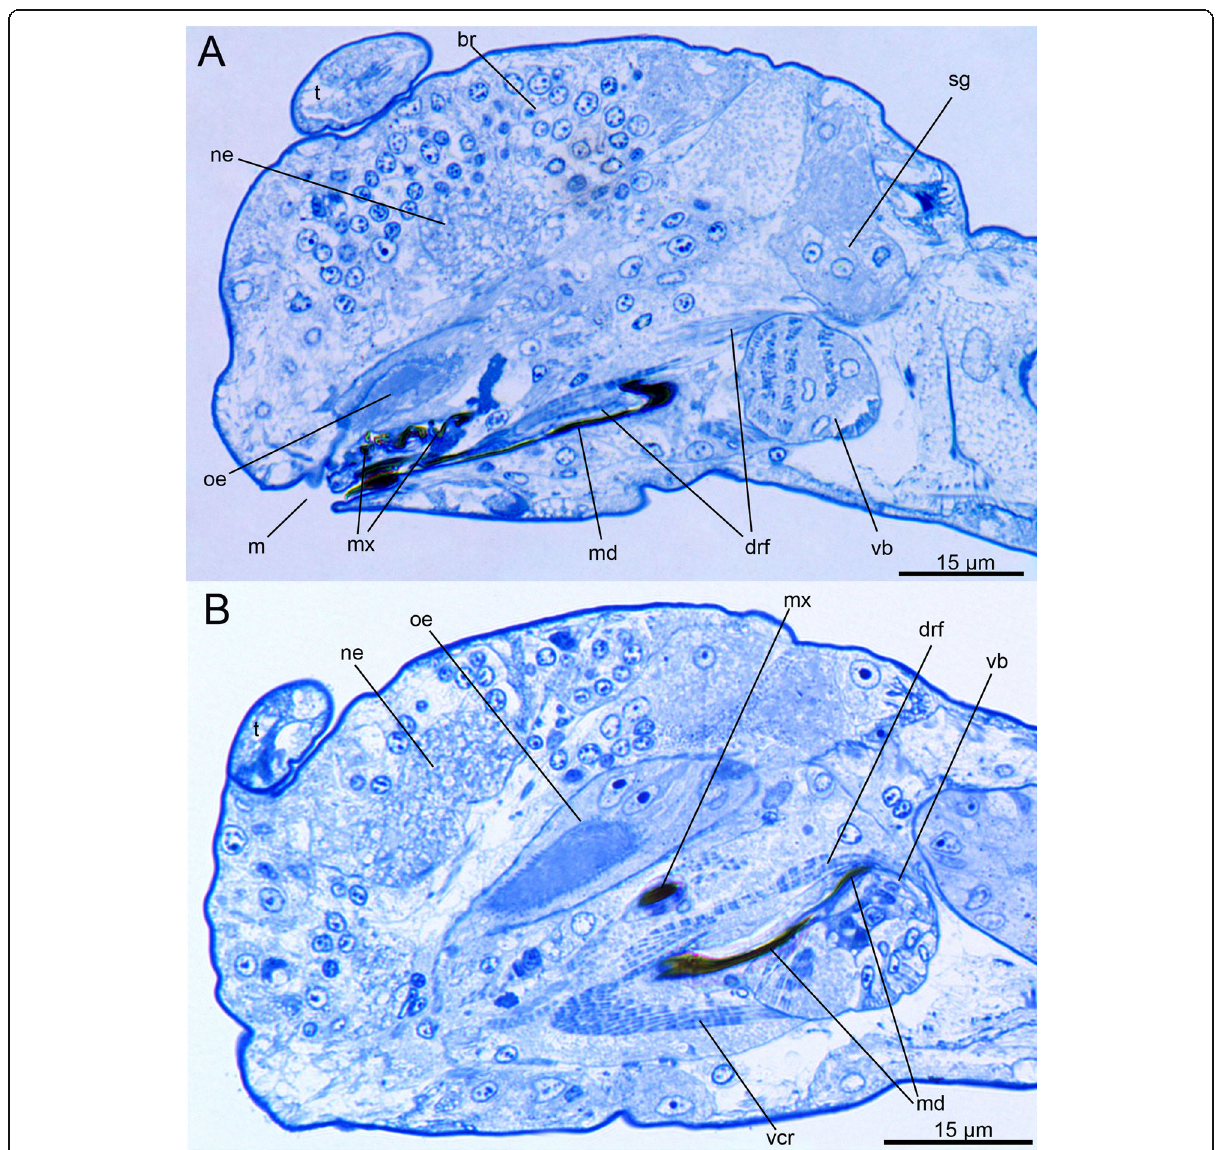
Fig. 1 General morphology of the anterior end of Histriobdella homari . Semithin sections, light microscopic images. a. Parasagittal section through the mouth region. b. Parasagittal section through the muscular apparatus of the ventral pharyngeal organ and jaws. br, somata of the brain; drf, dorsal rod flexor; m, mouth; md, mandibula; mx, maxillae; ne, brain neuropil; oe, esophagus; t, tentacle; sg, salivary gland; t, tentacles; vb, ventral muscle bulb; vcr, ventral carrier